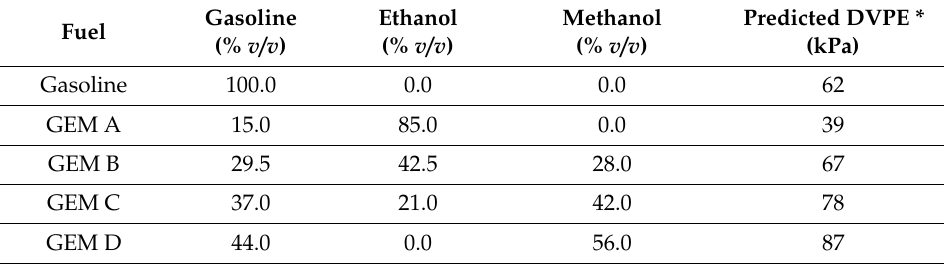
Table 6. Composition of the GEM fuels tested in the single-cylinder DI